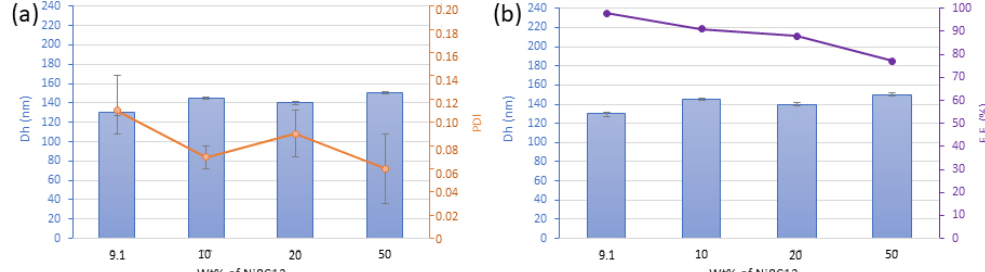
Figure 5. ( a ) Evolution of NPs hydrodynamic diameter (Dh) and dispersity (PDI) measured by DLS, as a function weight percent of Ni8C12, and ( b ) evolution of NP hydrodynamic diameter (Dh) and encapsulation efficiency (E.E.) as a function weight percent of Ni8C12 (for E.E., only one measurement was performed).